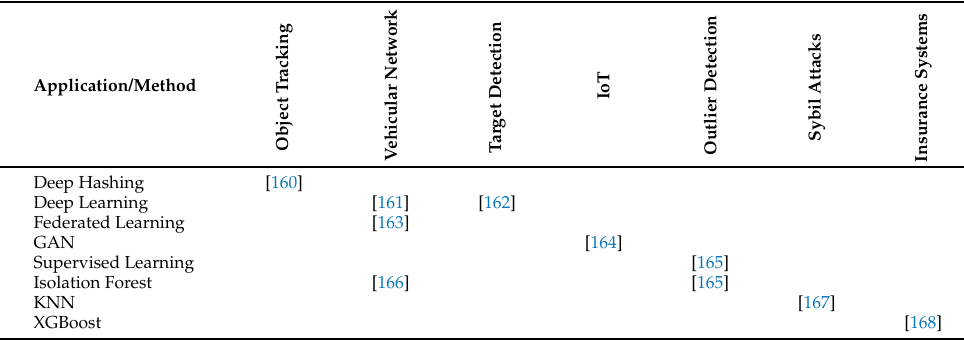
Table 10. IoT fraud